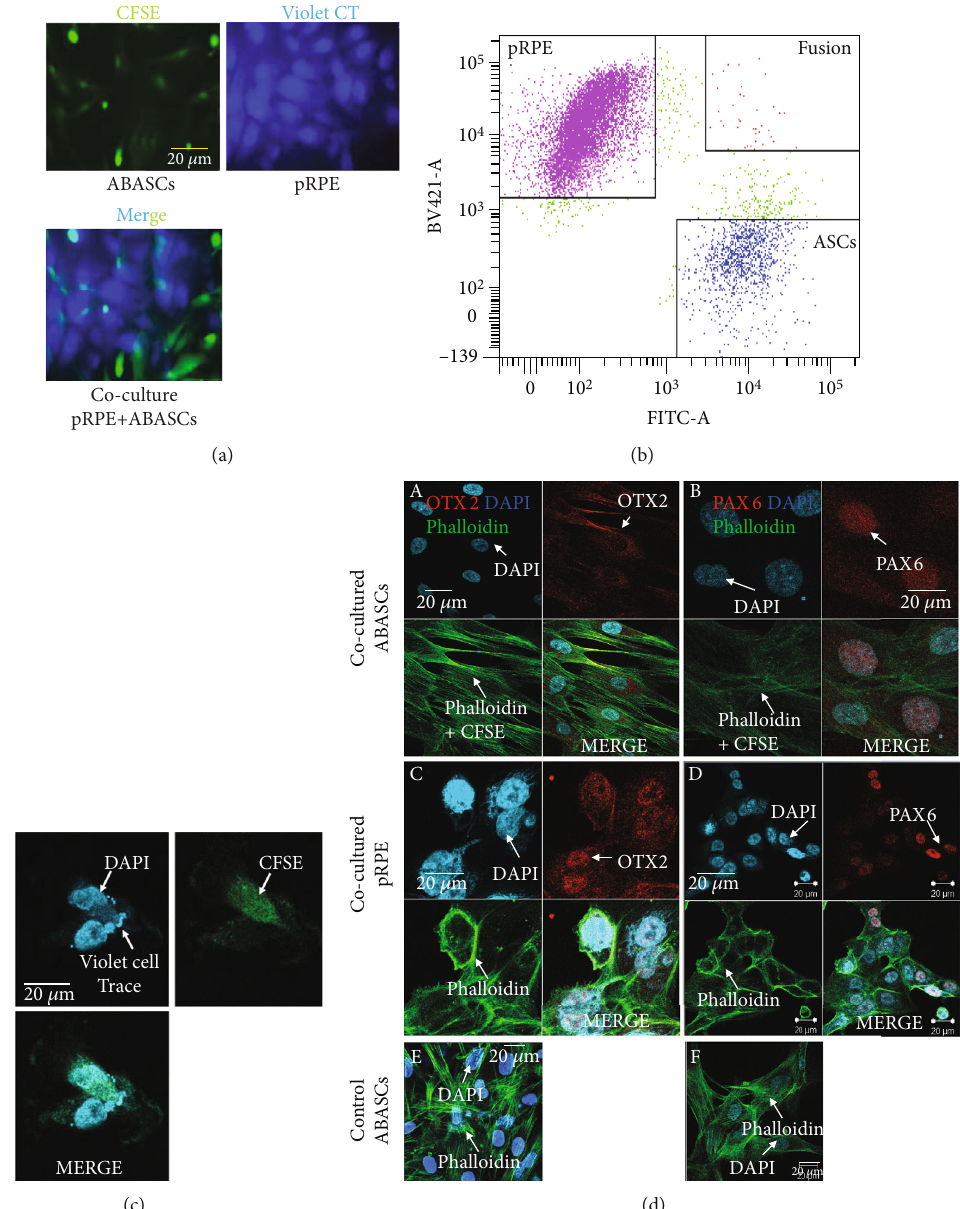
Figure 4: Di ff erentiation potential of ABASCs to retinal precursors cells. (a, b) Coculture of p-RPE and ABASCs. (a) Prestaining of cells: ABASCs were marked with CSFE (green color), and RPE mature cells were marked with Violet Cell Trace (blue color). (b) FACS sorter: three distinct populations are de fi ned after coculture: RPE, ABASCs, RPE and ABASCs which were fused together. (c) Fusion of cells as shown by one cell expressing both Violet Cell Trace (RPE tracer) and CFSE (OASC tracer). (d) Evidence of di ff erentiation potential of ABASCs to retinal precursors cells by immuno fl uorescence. (A) Sorted ABASCs expressing cytoplasmic OTX2. (B) Sorted ABASCs in CFSE showing nuclear localized PAX6 expression. (C, D) Positive control of sorted RPE cells in Violet Cell Trace showing nuclear localized OTX2 expression and nuclear localized PAX6 expression (E, F) negative controls of undi ff erentiated ABSCs does not show any OTX2 expression and PAX6 expression. CT: cell trace. n = 3